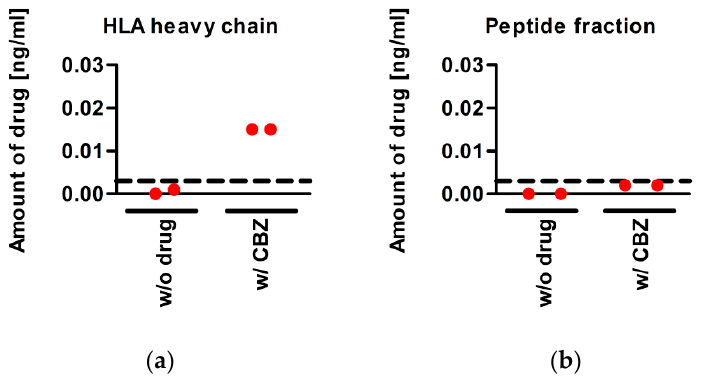
Figure 4. CBZ is detected after purification of the trimeric HLA molecules and further separation into ( a ) the retentate containing the HLA heavy and light chain and ( b ) the peptide fraction.